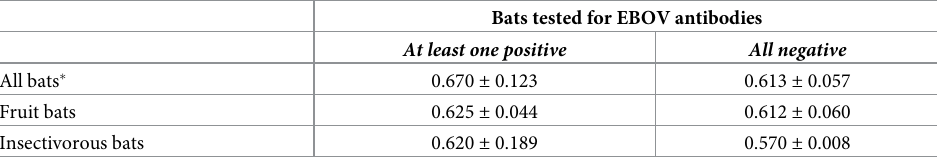
Table 4. Mean ± standard deviation of suitability index in sampling sites where at least one bat tested positive for Ebolavirus antibodies and where all bats tested negative. � Significance at p < 0.1 for